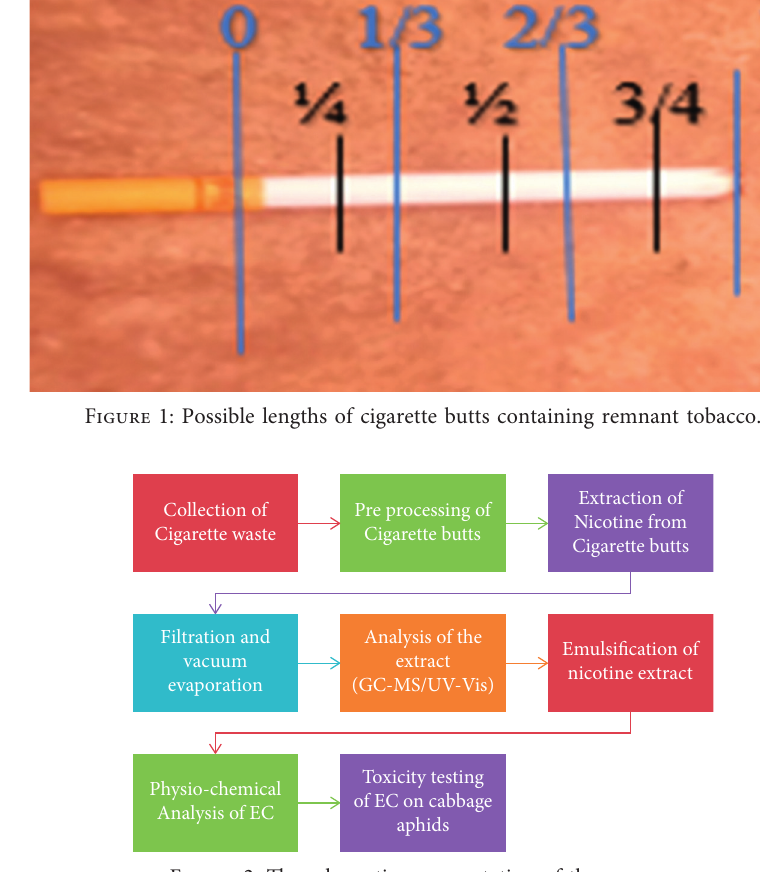
Figure 2: The schematic representation of the